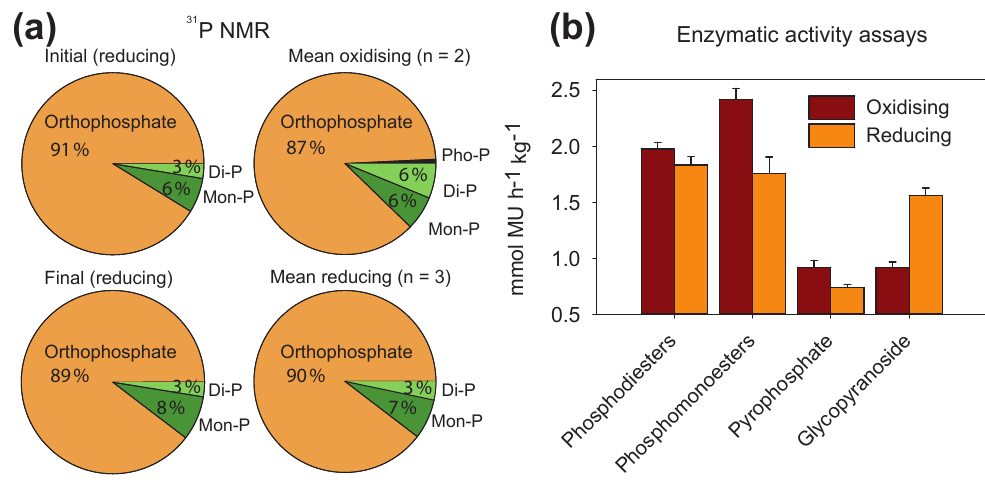
Figure 6. (a) P speciation determined by 31 P NMR for the initial suspension (top left), the final suspension (bottom left) and the average of samples from oxic conditions n = 2 (top right), the average of samples from anoxic conditions n = 3 (bottom right). Pho-P is phosphonates, Di-P is diester P and Mon-P is monoester P. Polyphosphate was not detected at concentrations > 1% in any of the samples